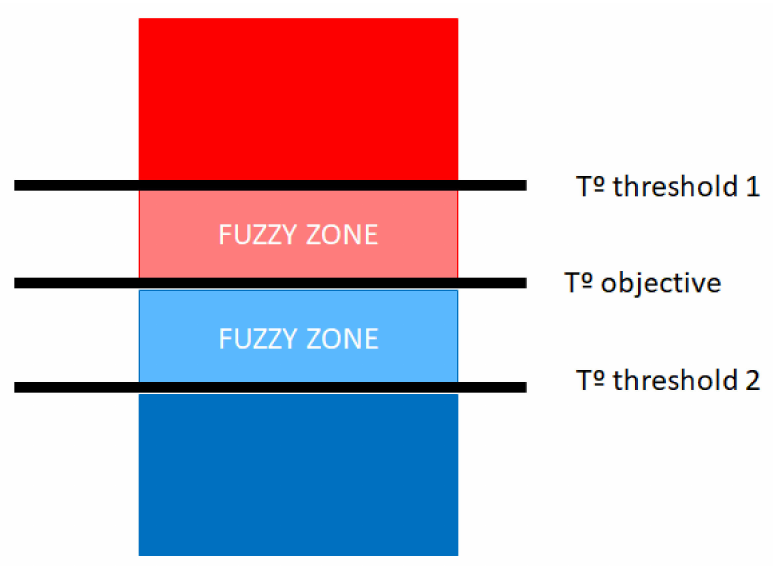
Figure 3. Representation of the proposed state diagram controller